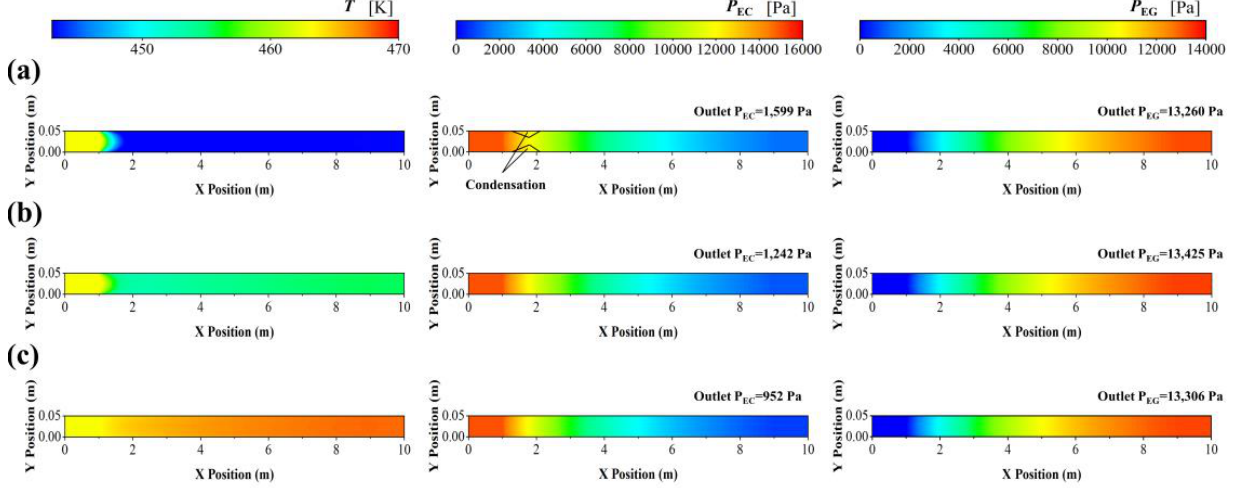
Figure 6. Contours of T , P EC and P EG in oil-cooled reactor with different coolant temperatures of